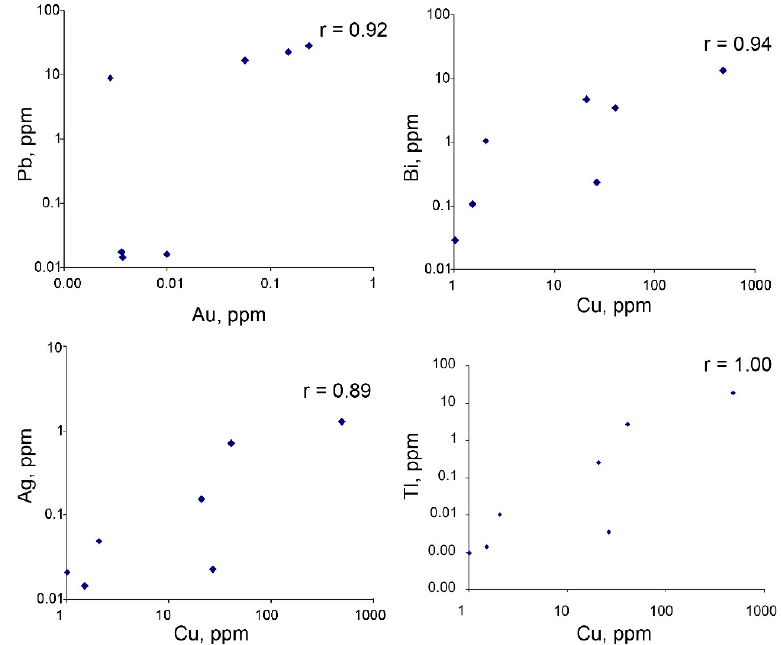
Figure 11. Log ‐ log plots for selected trace elements in coarse ‐ crystalline pyrite (ppm).